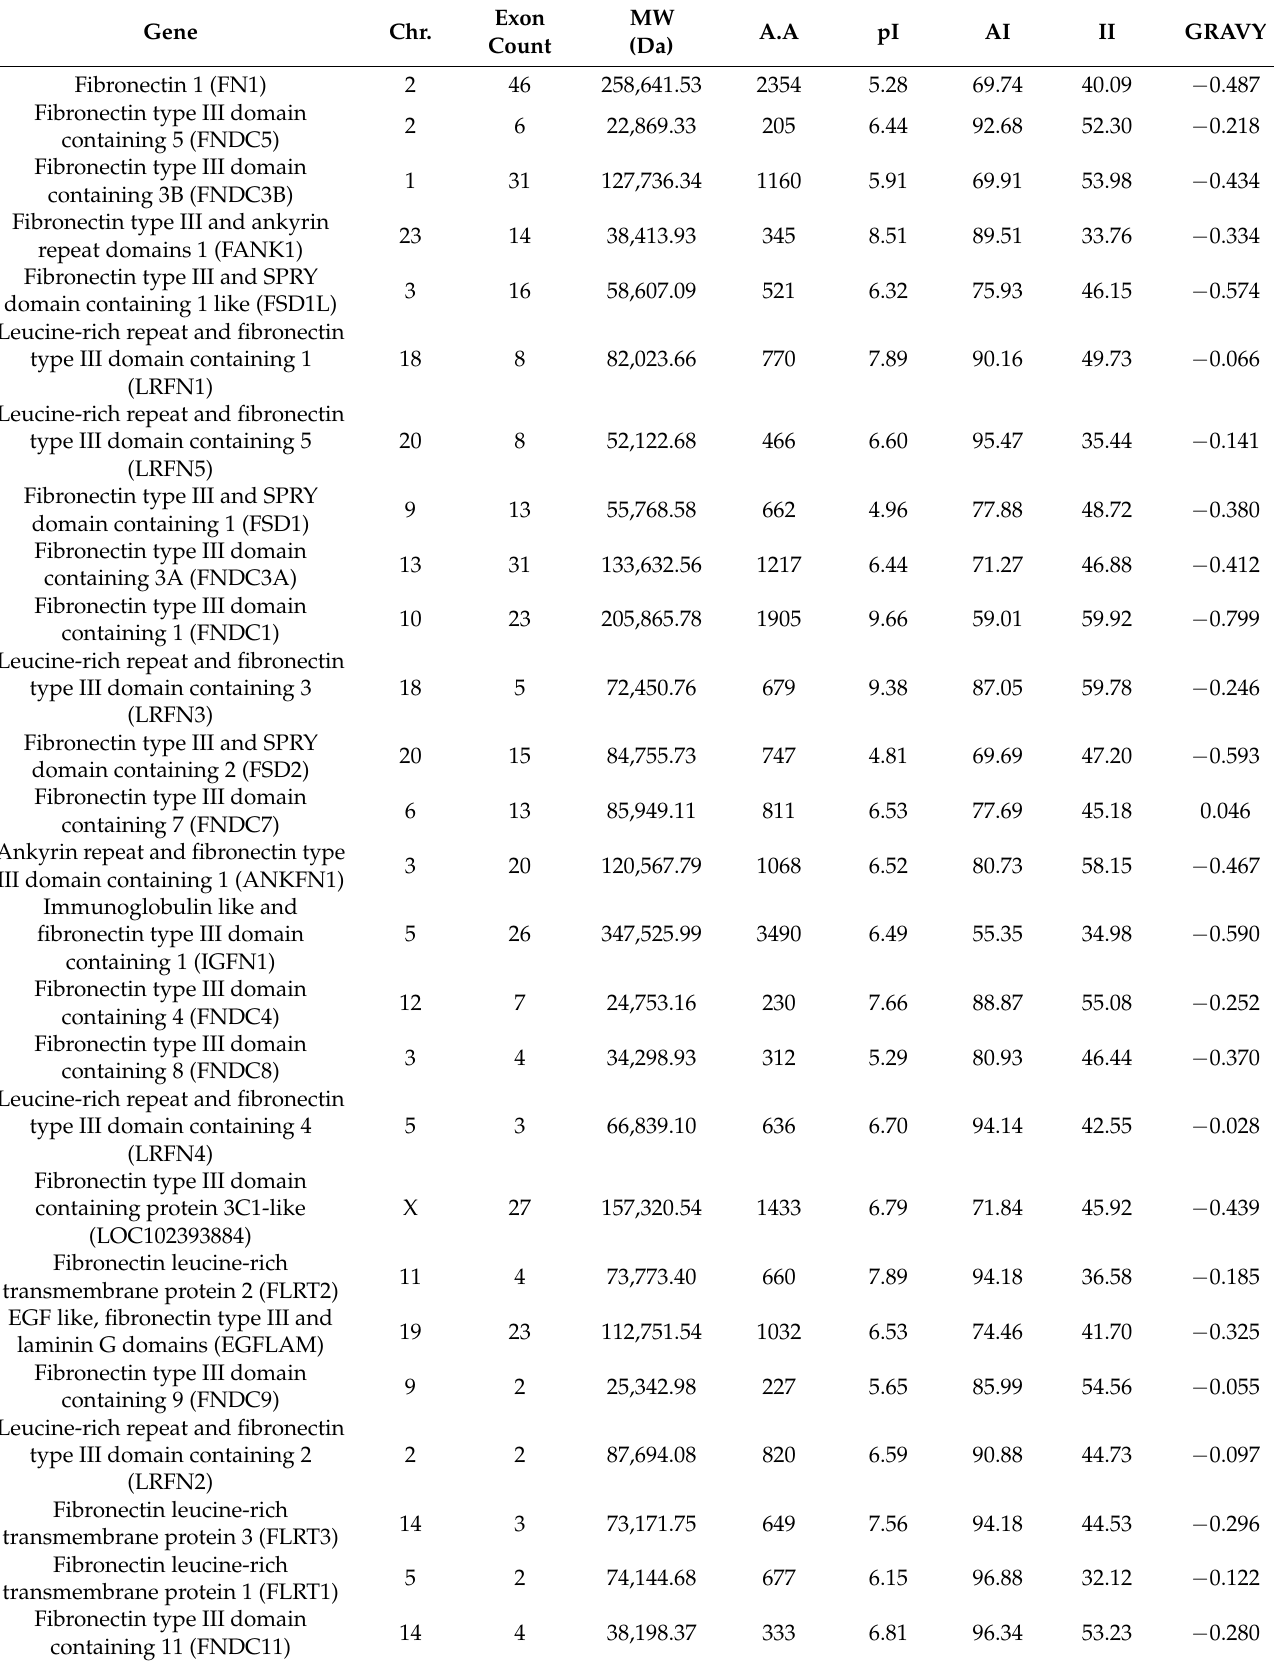
Table 1. Physiochemical properties of the fibronectin gene family in Bubalus bubalis.